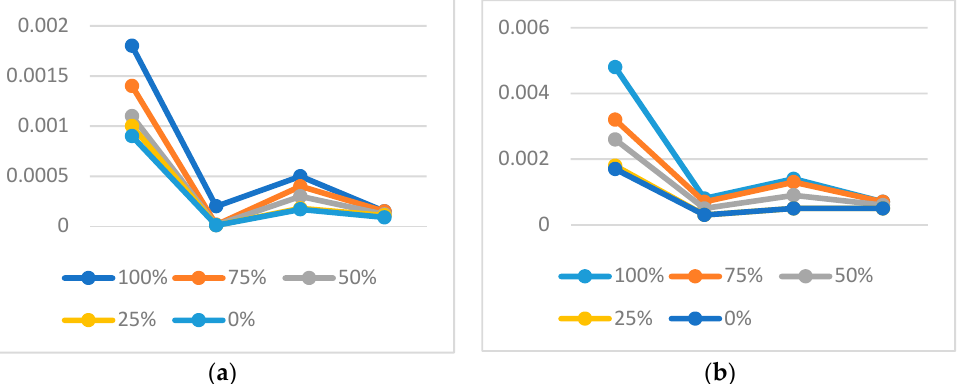
Figure 8. Highest frequency amplitudes between 5 kHz steps of Y-axis of ( a ) idle signal and ( b ) stroke signal.